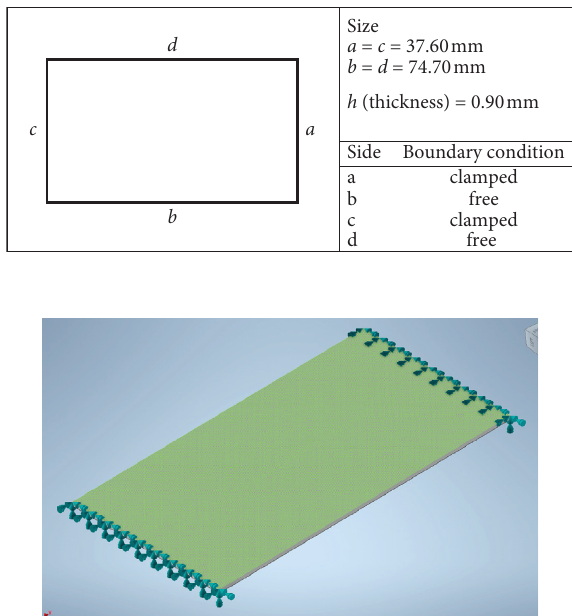
Table 3: Geometrical properties and boundary conditions (Case